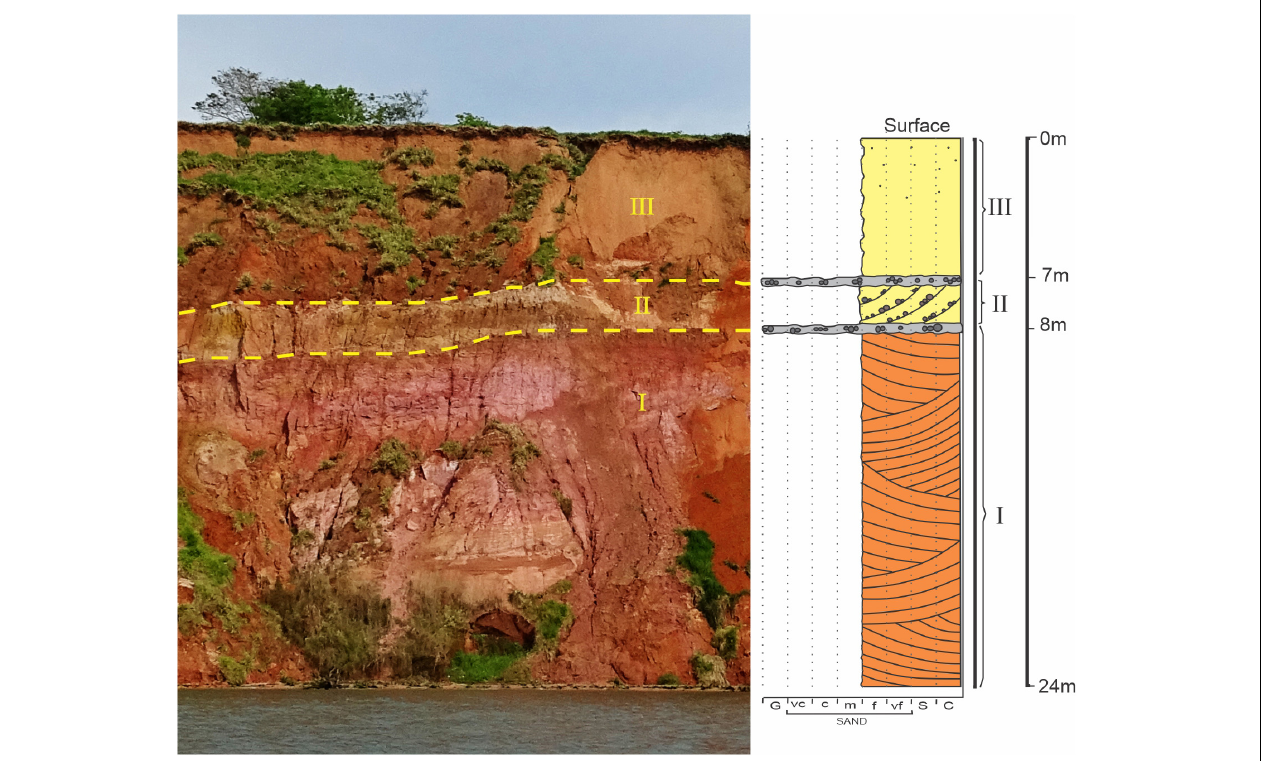
FIGURE 5 | Sedimentary profile of the Paredão das Araras (right margin of the Paraná River). Three distinct sedimentary packages were identified, from base to top: aeolian sandstones with cross stratification of the Caiuá Group (Cretaceous); intermediate package – unconsolidated deposits of fine to medium grained sands, light gray in color, poorly sorted and with pebbles and through cross stratifications that are not very marked; upper package – unconsolidated sediments of fine to medium sand and reddish brown color, with subrounded grains and presence of rounded